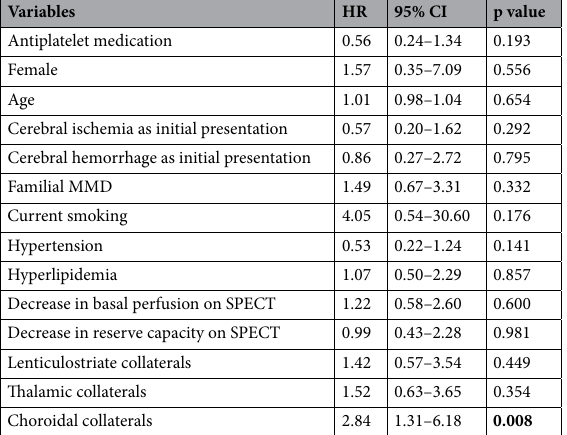
Table 4. Logistic regression analysis of symptomatic cerebral hemorrhage associated with antiplatelet medication during the follow-up. p < 0.05 statistically significant (marked in bold). MMD moyamoya disease, SPECT single photon emission computed